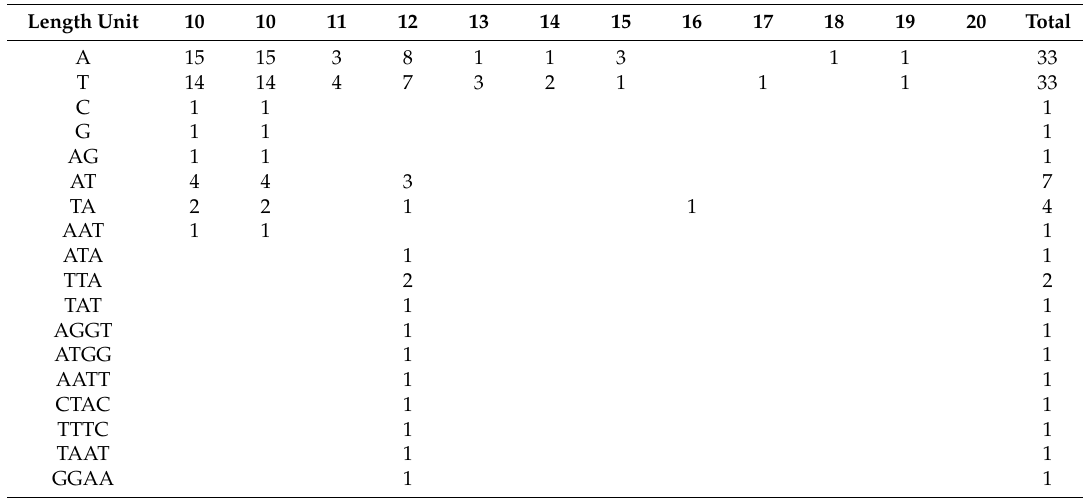
Table 6. Frequency of simple sequence repeats in the T. paniculatum chloroplast genome.